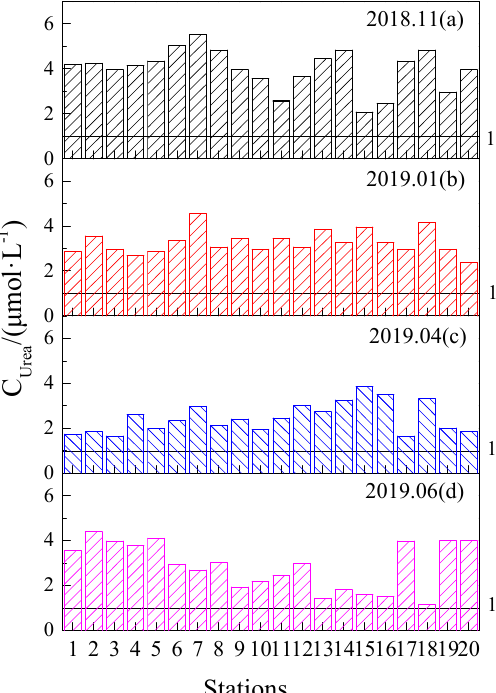
Figure 5. Assessment of DON bioavailability based on urea concentration in the ZJB coastal